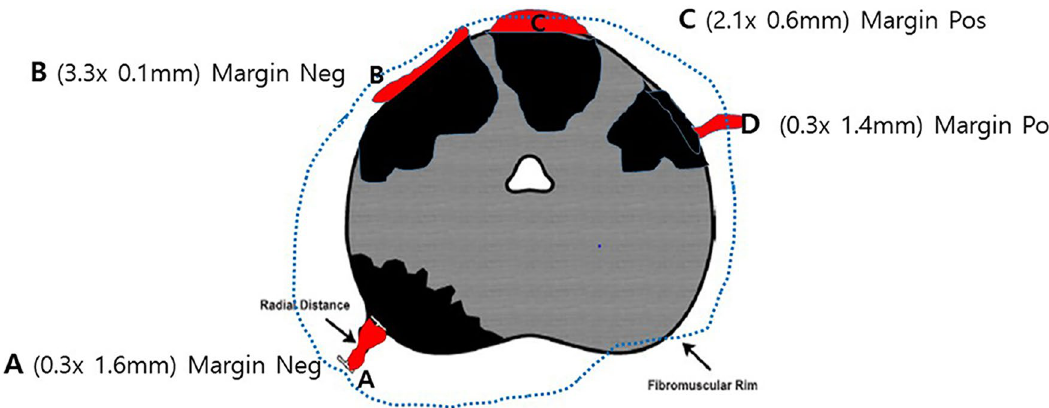
Figure 3. Schematic diagram of various cases of EPE. In general, EPE erupts from the origin of the tumor nodule. In cases of multifocal tumor nodules, which are frequently observed, multiple EPE foci can be present. When only radial distance is measured, the “A” type could be an EPE index because it is the longest in radial distance. However, in comparison with 2D areas that include circumferential length, the “C” type can be an EPE index. Another dilemma is whether EPE is associated with circumferential margin involvement. The combination of “C” type in 2D or “D” type in radial distance could be a more useful EPE